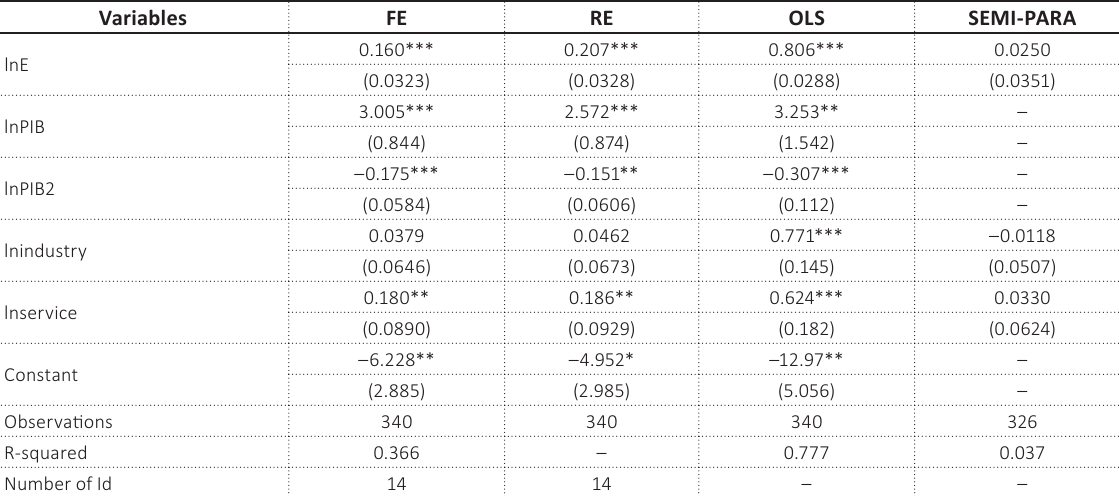
Table 6. Estimate with methane